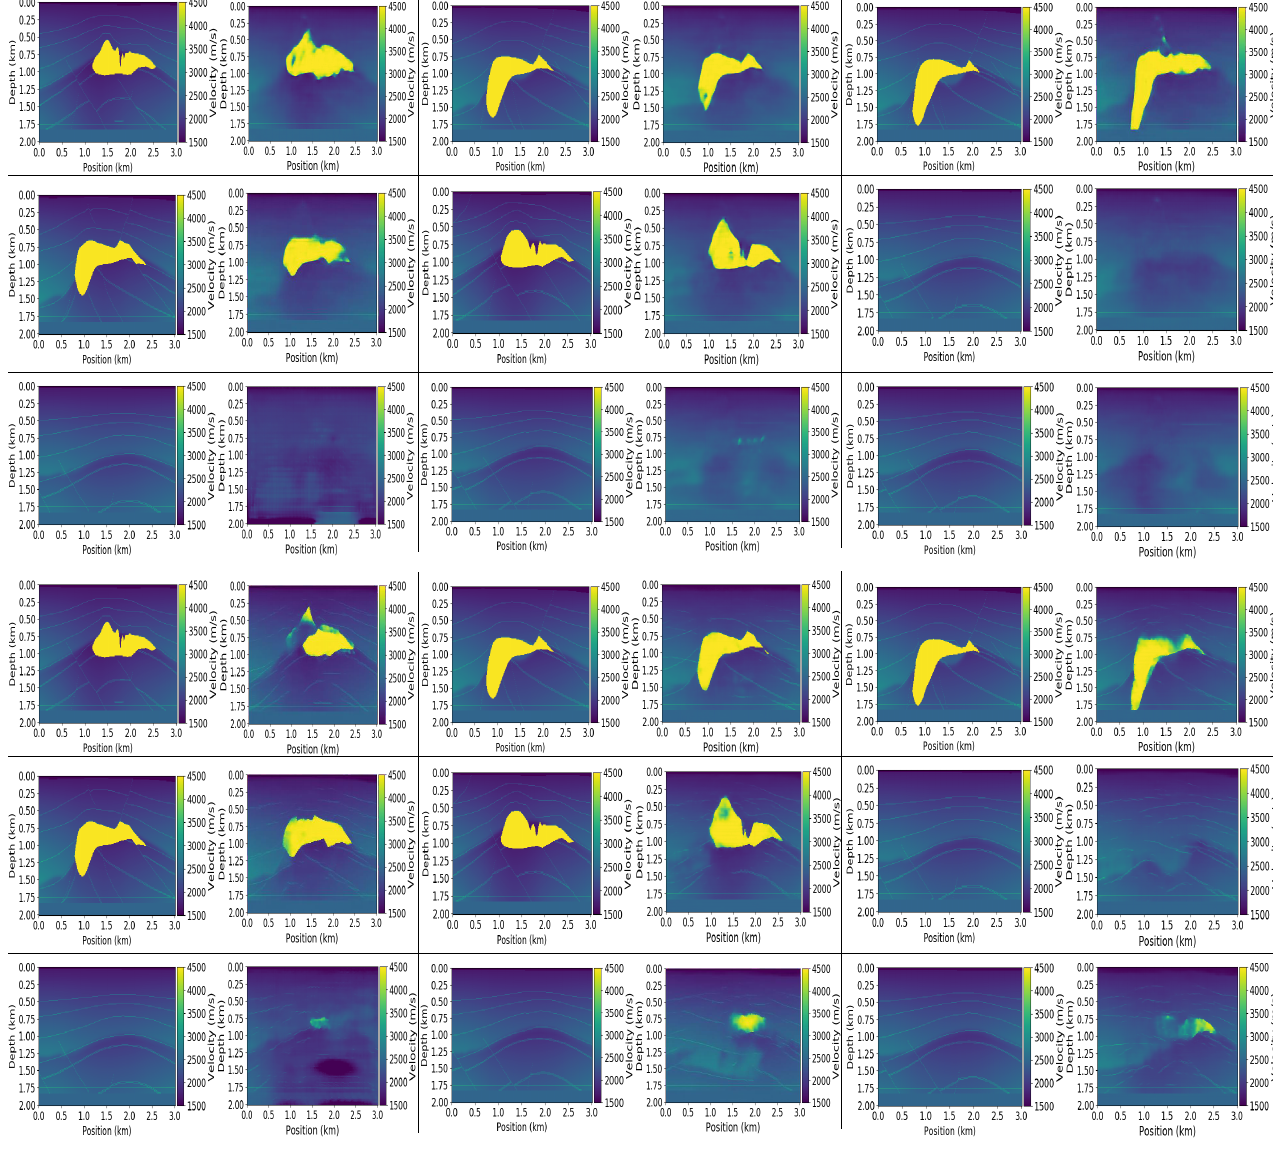
Figure 10. Reconstruction results for no-noise ( top ) and noise-aware ( bottom ) models on the Salt data. Ground truth ( left ) and Prediction ( right